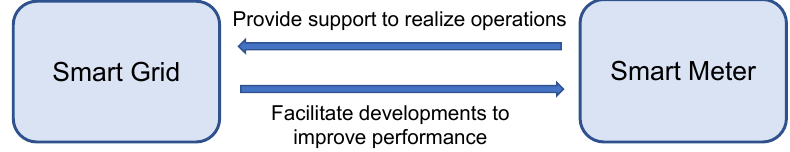
Figure 1. The relationship between smart grid and smart